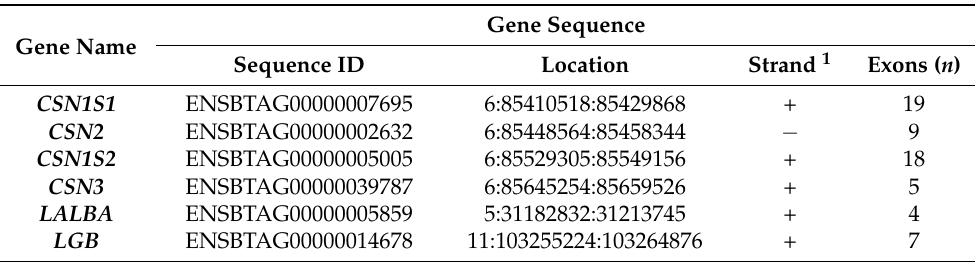
Table 1. Reference gene sequences used to investigate milk protein gene polymorphisms in the Beninese indigenous cattle